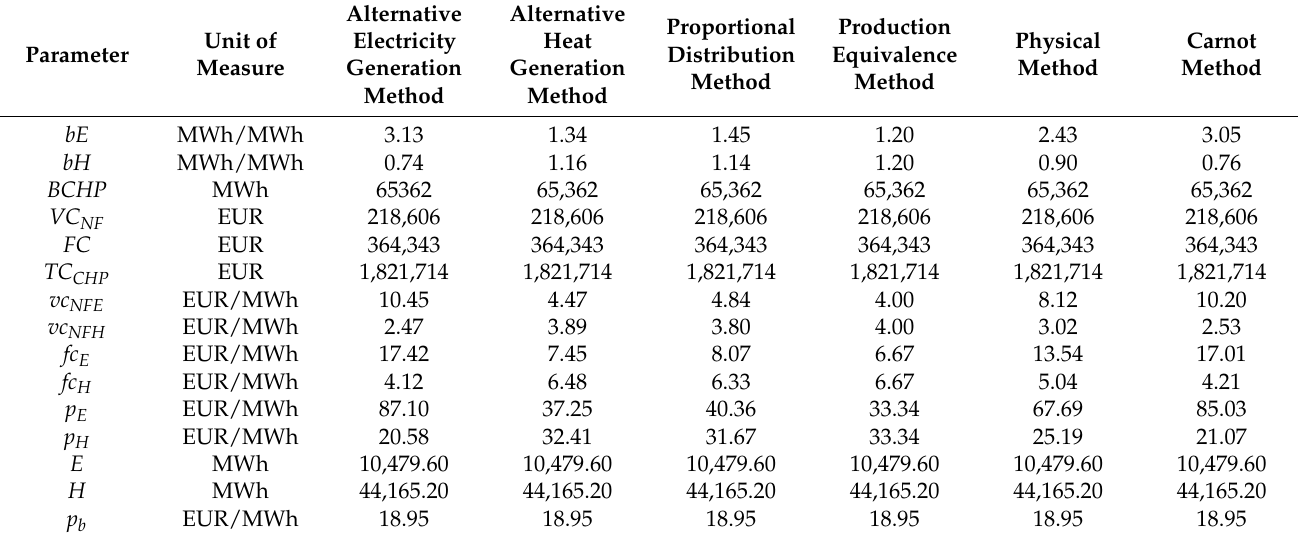
Table 3. Summary of results in the reference